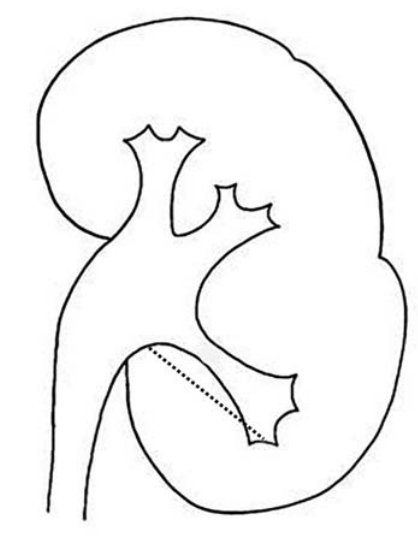
Figure 2 – Infundibular length (mm), measured as the distance between the most distal point of the calyx containing the calculus and the midpoint of the lower lip of the renal pelvis.